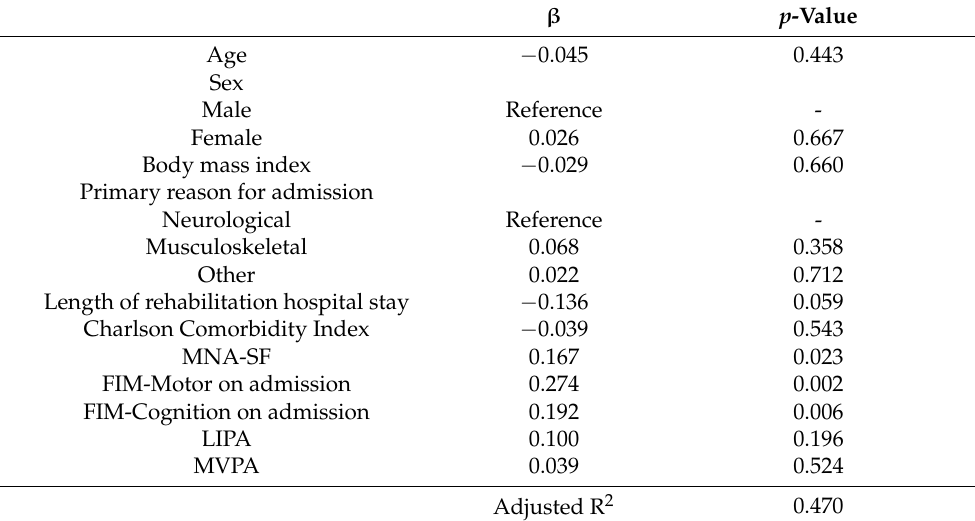
Table 3. Multivariate linear regression analysis for FIM-Motor score at discharge.